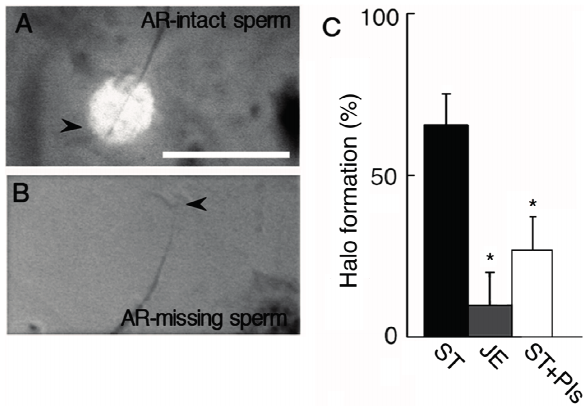
Figure 1. Digestion of gelatin film by sperm acrosomal protease. Sperm were put on a gelatin-coated glass slide and then air-dried. Gelatin was stained with Coomasie Brilliant Blue R-250. ( A ) An acrosome-intact sperm. A halo of gelatin digestion was observed as an unstained area around the sperm acrosome; ( B ) An acrosome-reacted sperm. No gelatin digestion was observed. Arrows indicate tip of sperm head. Bar: 25 µm; and ( C ) Decrease in percentages of the sperm with a halo of gelatin digestion by treatment with JE. * p < 0.01 against that in acrosome-intact sperm (Intact). ST: modified Steinberg’s salt